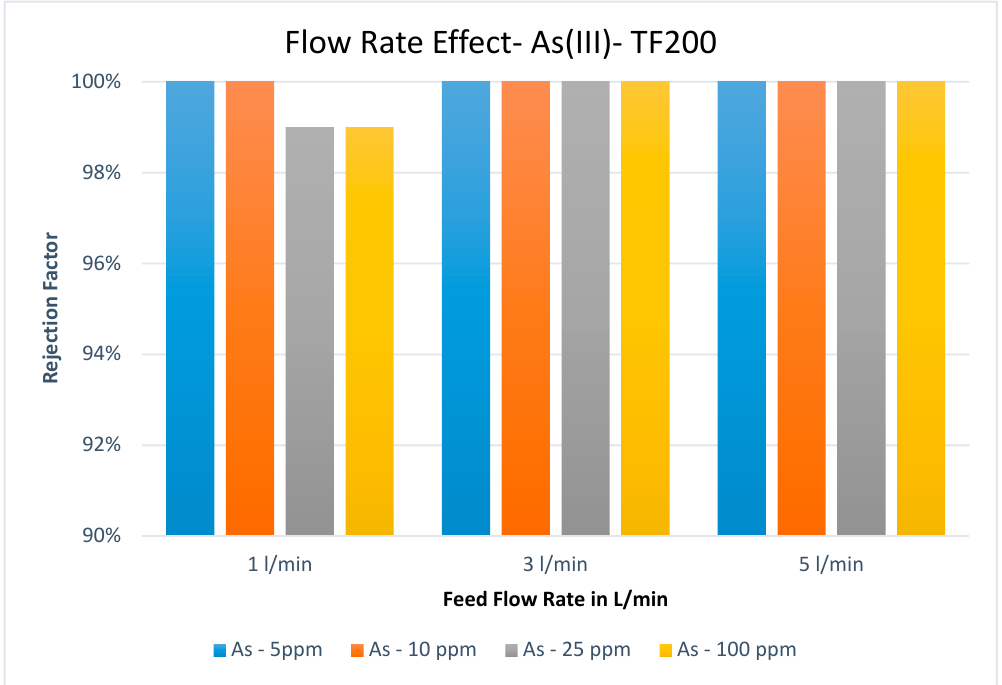
Figure 4. Effect of feed flow rate on the rejection factor using TF200 membrane for As(III) (feed temperature = 50 °C, condensing temperature = 10 °C).